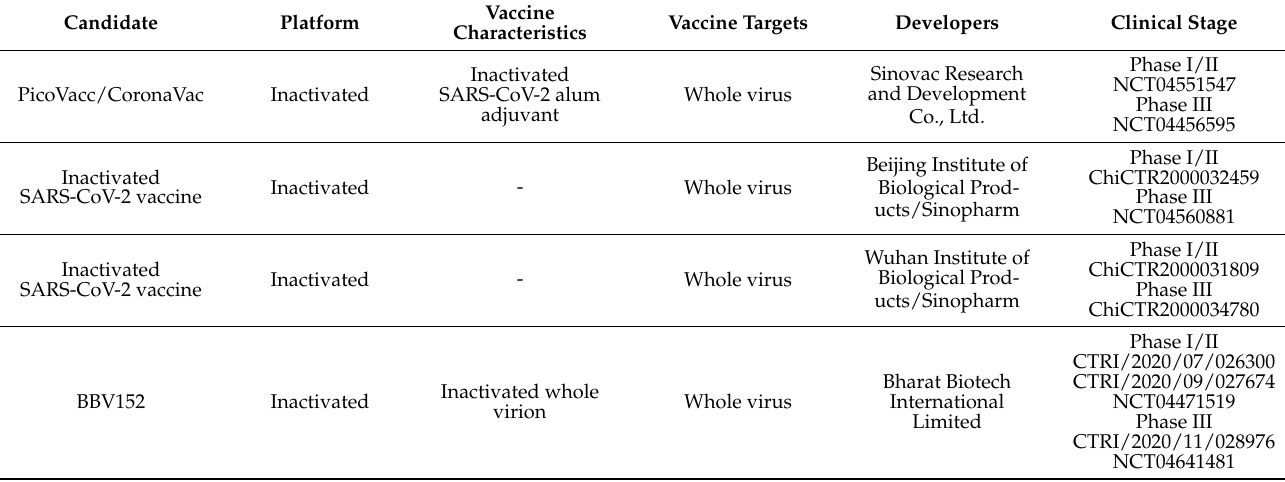
Figure 4. COVID-19 candidate vaccines. ( a ) The number of candidate COVID-19 vaccines in pre- clinical and clinical evaluation [9]. ( b ) The number of candidate COVID-19 vaccines in different phases of clinical evaluation [9]. (Data figures created by Juanita Mellet.) Table 1. Candidate vaccines in phase III of clinical evaluation.